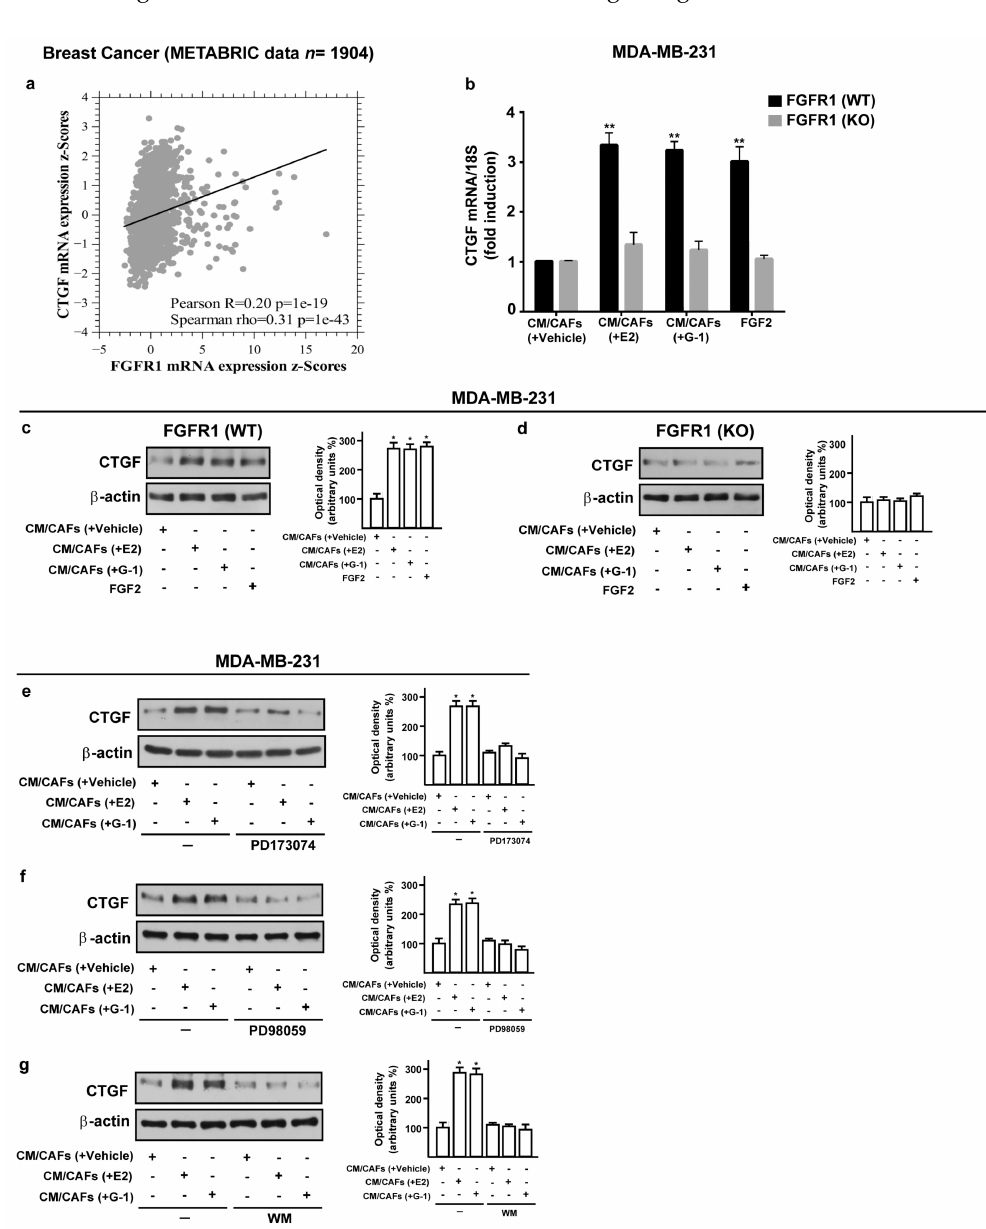
Figure 6. Conditioned medium (CM) from estrogen-stimulated CAFs up-regulates CTGF levels through FGFR1 signaling pathway in MDA-MB-231 cells. ( a ) Pairwise linear regressions of FGFR1 versus CTGF mRNA levels were performed on METABRIC dataset of 1904 breast tumor samples. Scatter plot